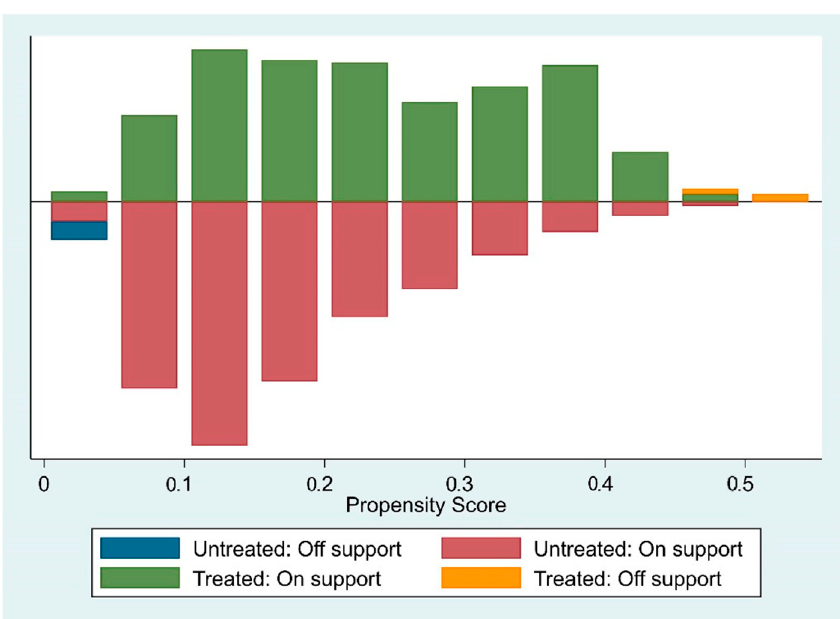
Figure A1. Standardized bias of each variable.